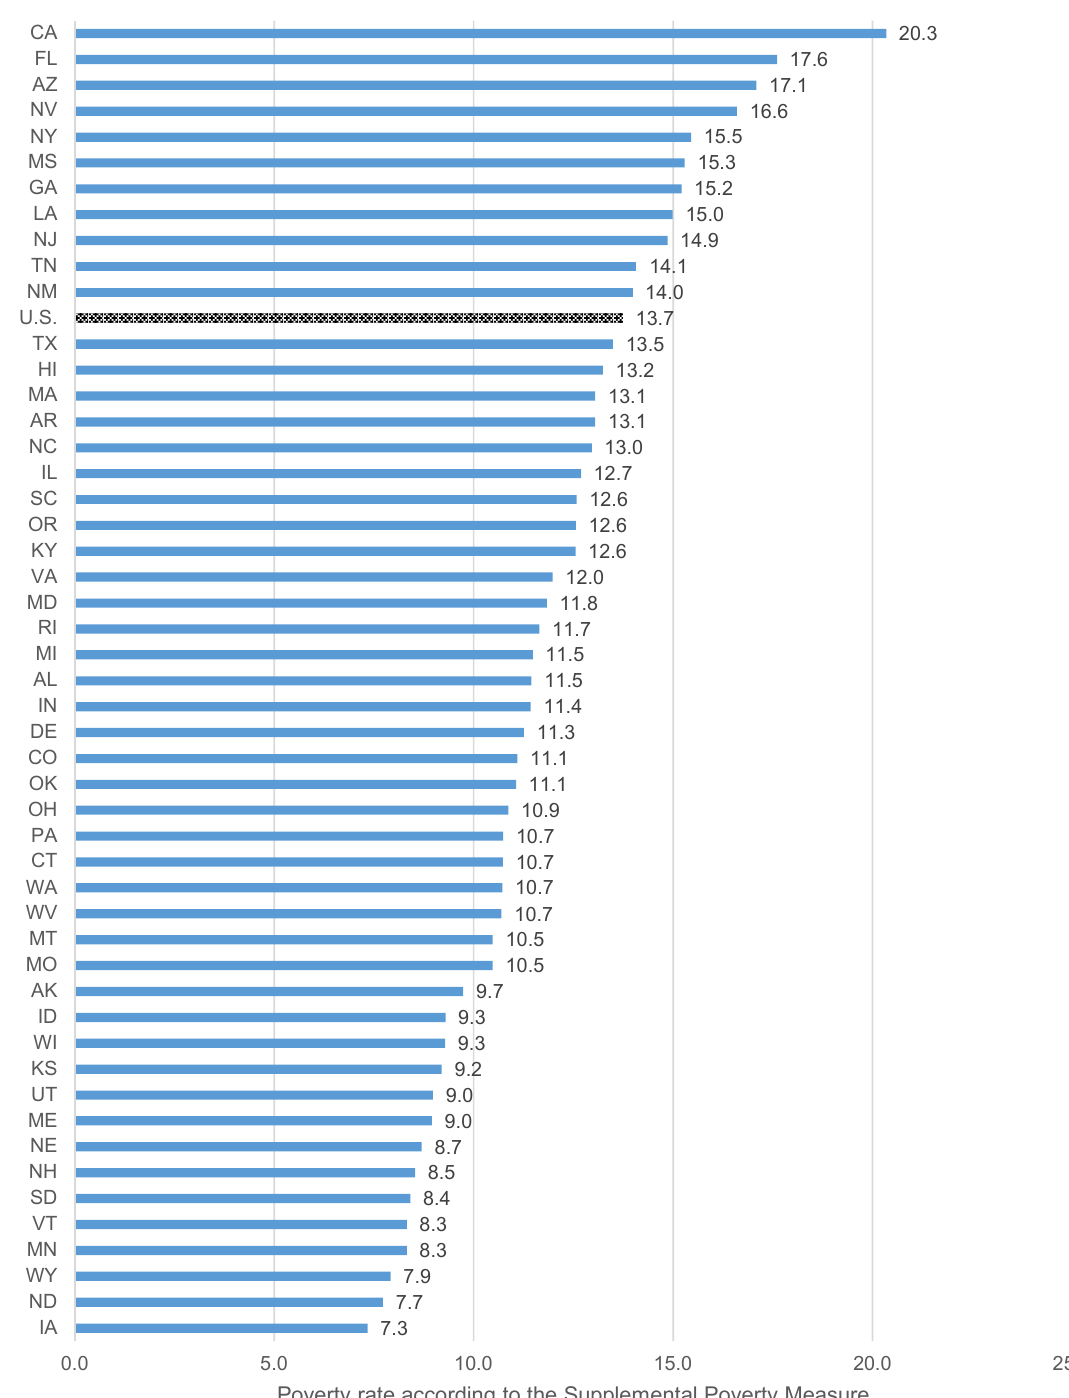
Figure 1: Poverty rates by state according to the SPM, adjusted for SNAP, SSI, and TANF underreporting (2012–2016 CPS). States are indicated by their postal code